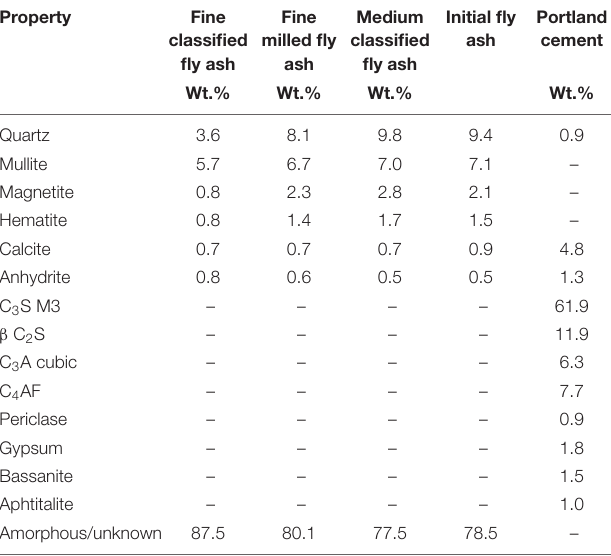
TABLE 2 | Phase composition determined by XRD-Rietveld analysis of the fly ashes and the Portland cement. Property